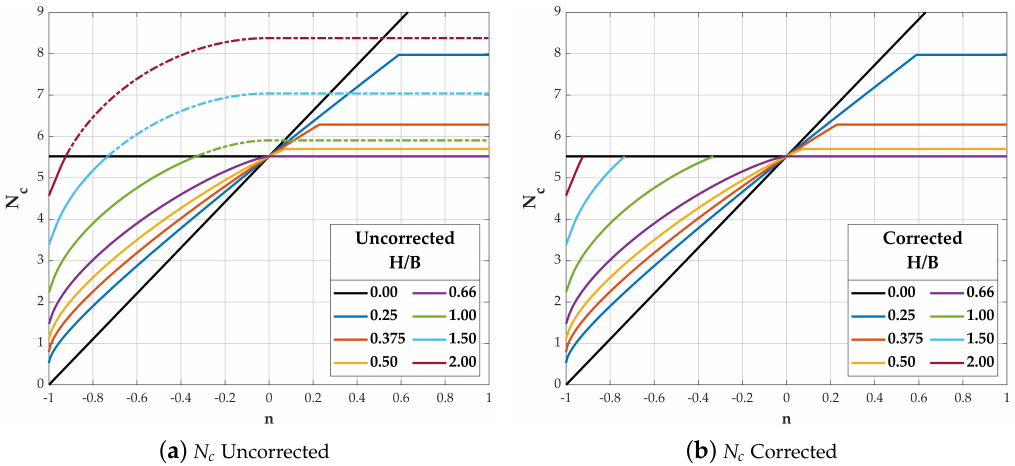
Figure 4. Bearing capacity factor N c of various relative strength and normalized layered thickness for strip